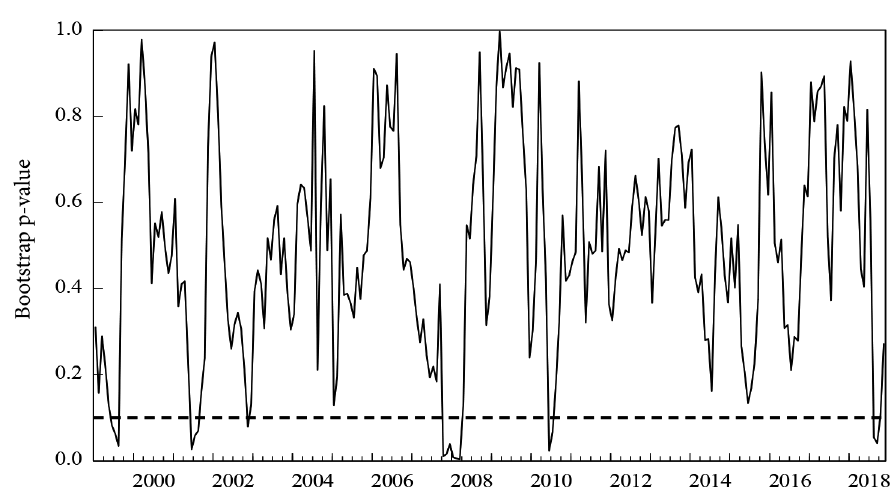
Figure 1. Bootstrap p -values of rolling test statistic testing the null hypothesis that GEPU does not Granger cause GP